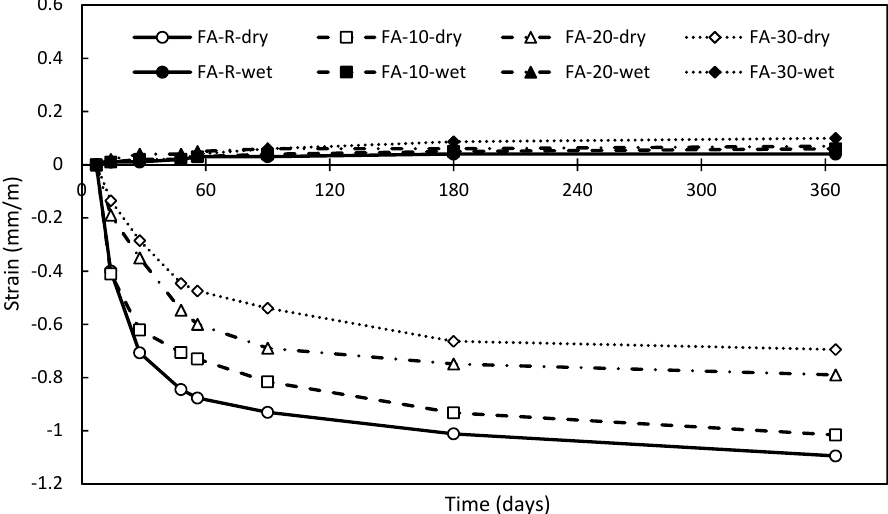
Figure 12. Results of shrinkage measurement of studied mixtures in time.